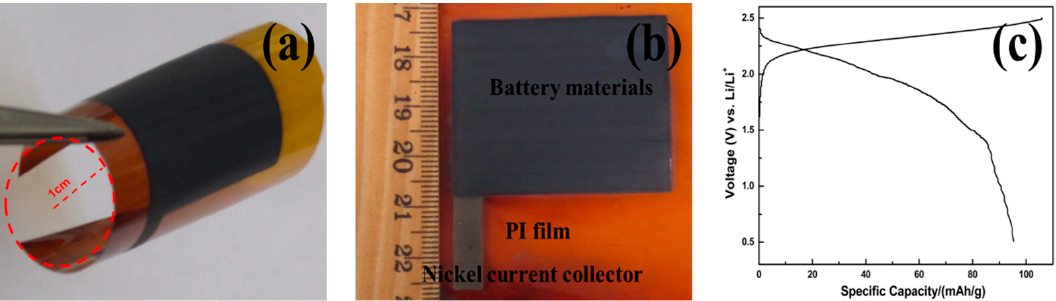
Figure 9. ( a ) Flexibility of printed nickel electrodes without battery materials; the radius of curvature is around 1 cm; ( b ) structure of flexible electrodes made by inkjet printing; ( c ) first charge-discharge of the assembled battery.